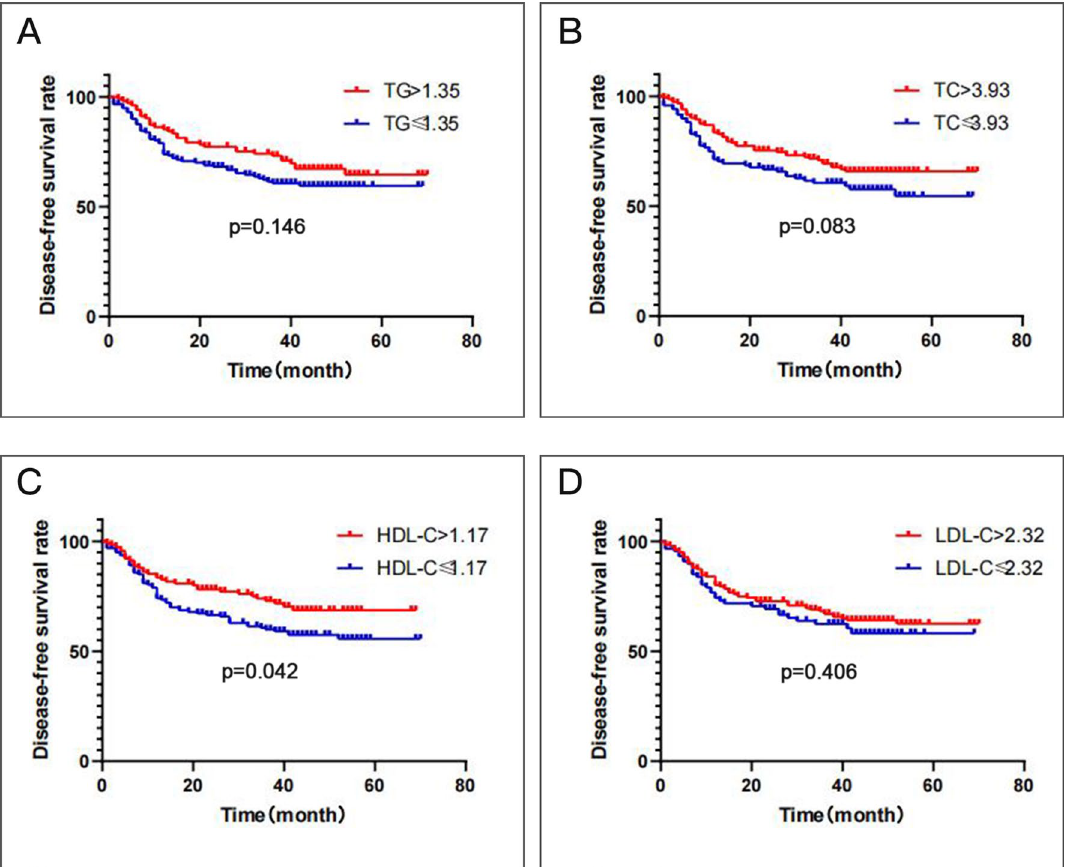
Figure 4. Kaplan–Meier curve for disease-free survival regarding low vs high TG levels (P = 0.146) ( A ); low vs high TC levels (P = 0.083) ( B ); low vs high HDL-C levels (P = 0.042) ( C ); low vs high LDL-C levels (P = 0.406) ( D